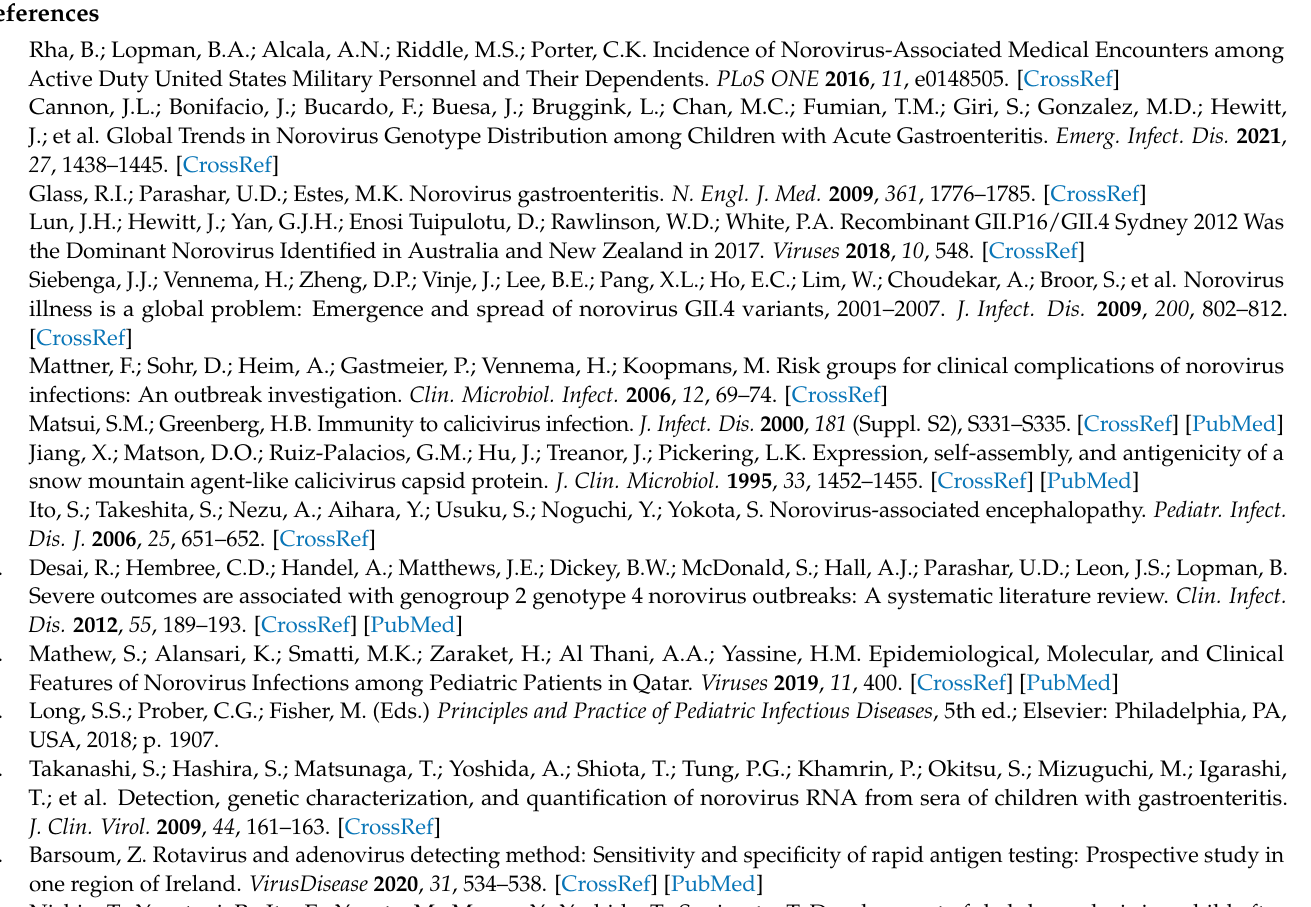
Table S2: Reagents used in the reverse transcription (RT)